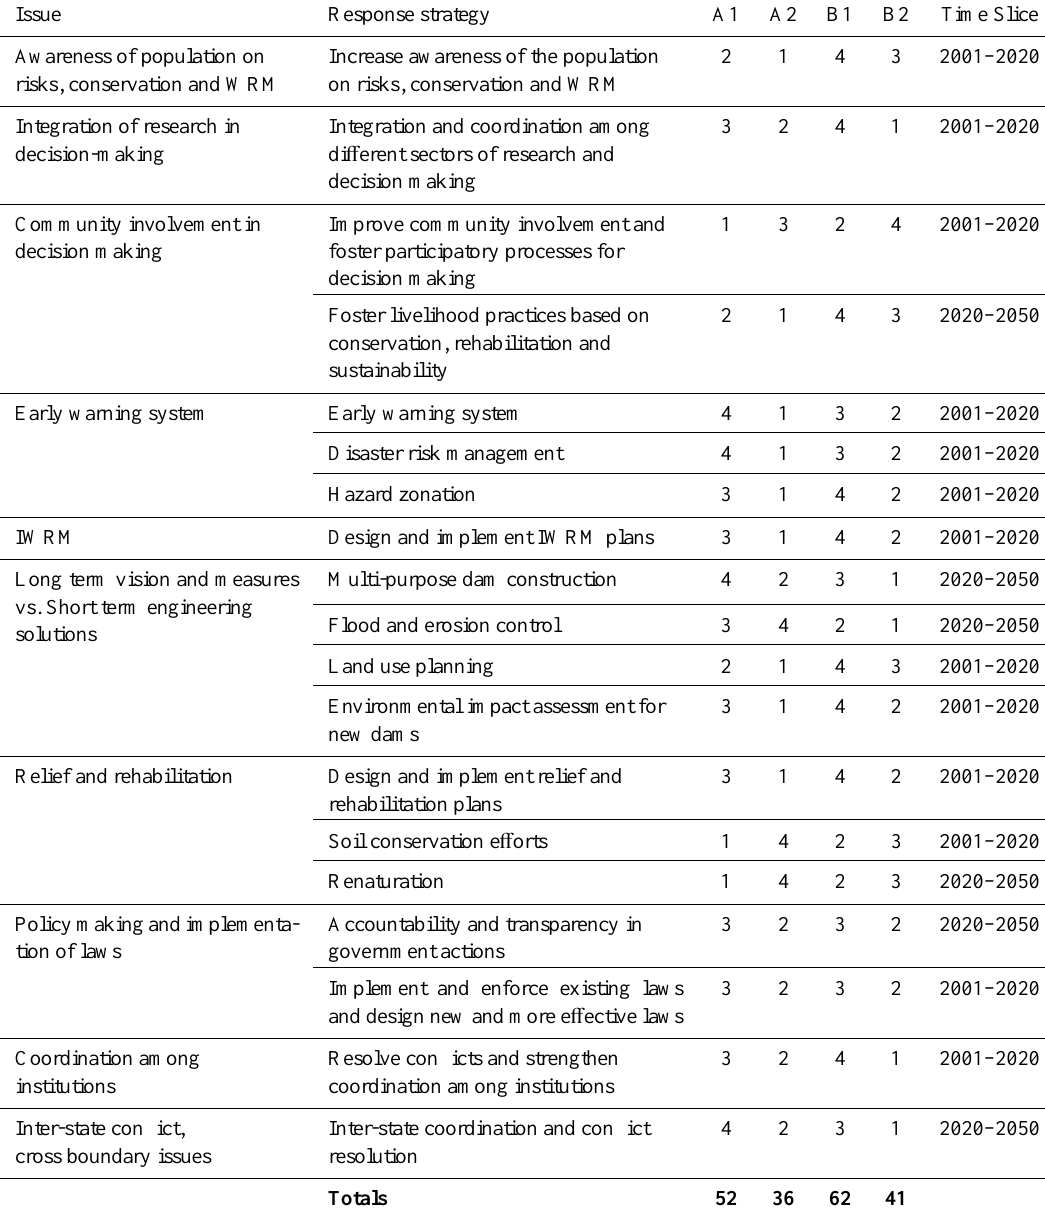
Table 3. Evaluation of suitability of Assam response strategies against projected governance characteristics of SRES